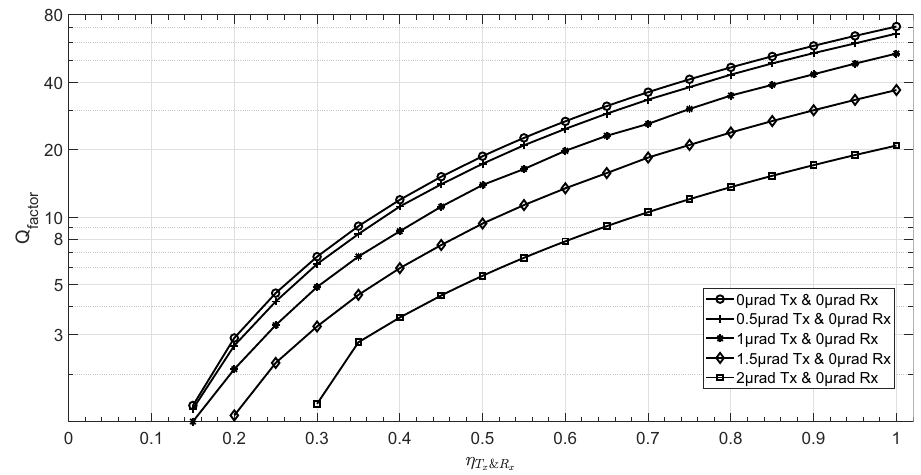
Figure 11: Quality factor ( Q factor ) as a function of the telescope e ffi ciency with only transmitter di ff erent pointing